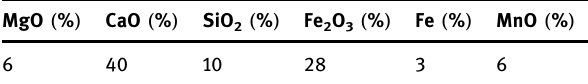
Table 3: Chemical compositions of steel slag